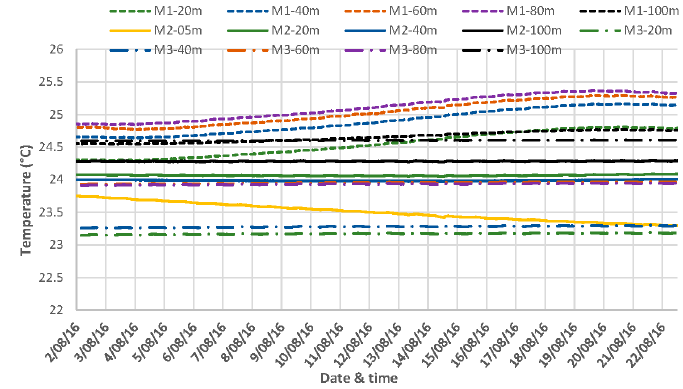
Figure 9. Heat rejection (HR) boreholes temperatures of CW system with different depths as indicated between August 1 and August 22, 2016.